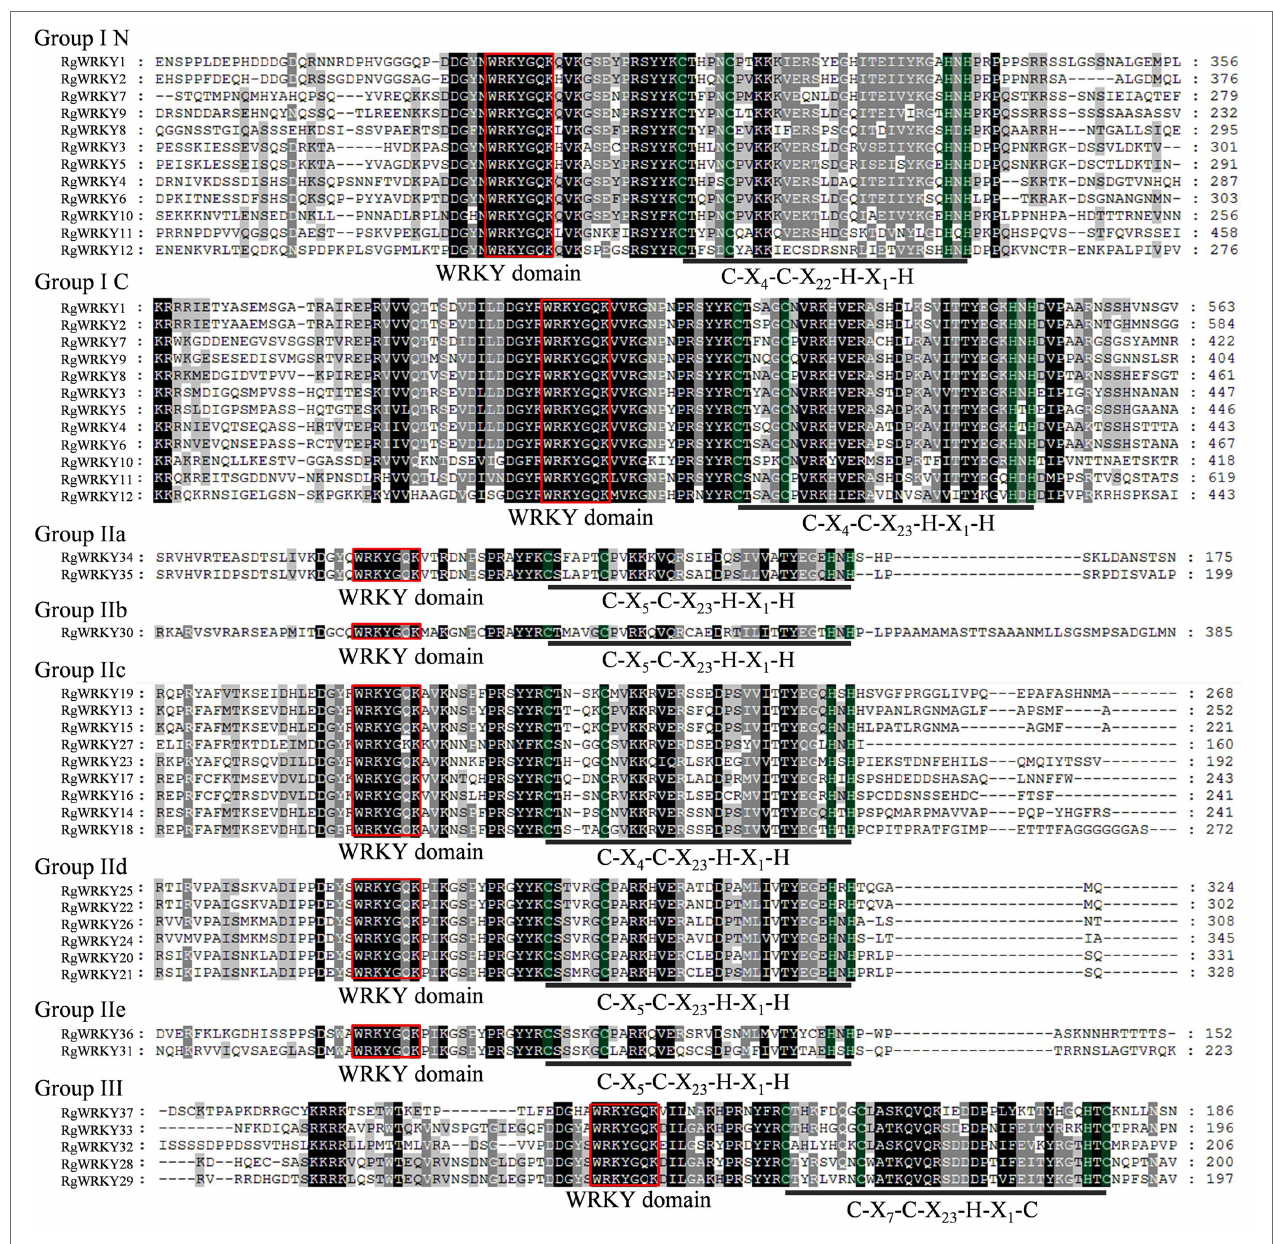
FIGURE 3 | Multiple sequence alignment of the WRKY domain among R. glutinosa WRKY genes. Red indicates conserved WRKY amino acid domains; green indicates zinc finger motifs; and dashes indicate gaps. “N” and “C” indicate the N-terminal and C-terminal WRKY domains of a specific WRKY